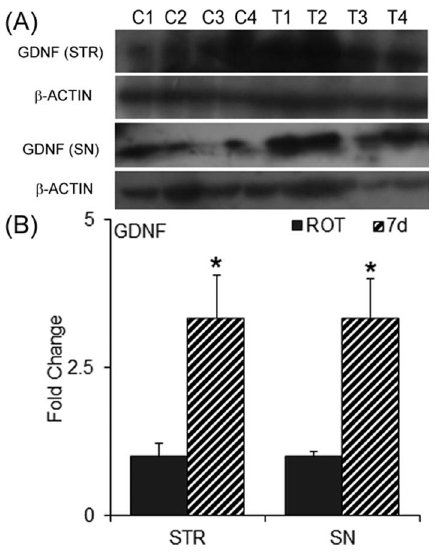
Figure 12. Neurons in the nigra of the animals that received unilaterally grafts in the striatum. Sections passing through the substantia nigra pars compacta were cut and immunostained for tyrosine hydroxylase (arrows; ipsilateral nigra) (A–C) or stained for neurons with cresyl violet (D–F). The sections passing through nigral region of the midbrain of rats that received the vehicle, without cells (A, D), undifferentiated embryonic stem cells (ES; B,E) or 7 days differentiated ES (7 d; C,F). There appeared a significant percentage of improvement in the total number of neurons in the ipsilateral substantia nigra relative to the contralateral side (G), and in TH-positive dopaminergic neurons (H). Results are presented as Mean 6 SEM. * p # 0.05, as compared to control or ES transplanted group. Sections from 3 different brain samples were considered for each group. protein level (Fig. 12A,B). We also found an increase in the protein levels of GDNF in the SN ipsilateral to the side of the 7 d transplanted group, when compared to the rotenone lesioned ipsilateral SN (Figure 12A,B). The increase was found to be almost 3-fold.